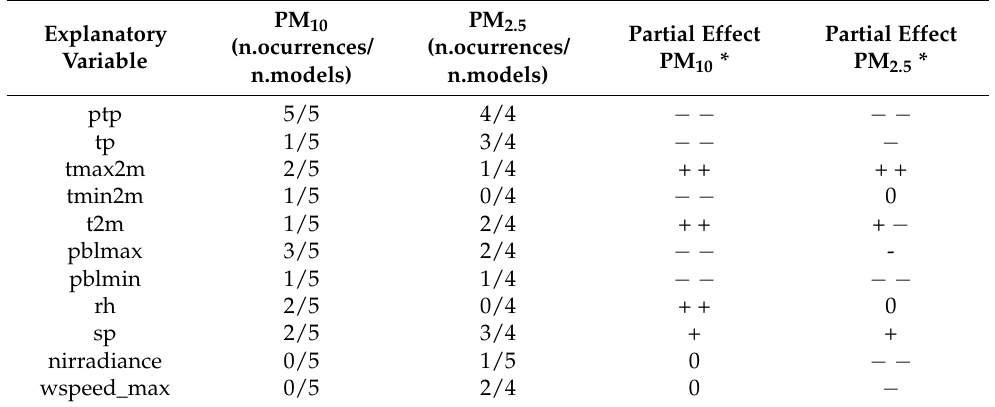
Table 5. Summary of qualitative partial effect on PM levels (derived from Figure 5 and Figures S1d–S8d) and number of occurrences of the explanatory